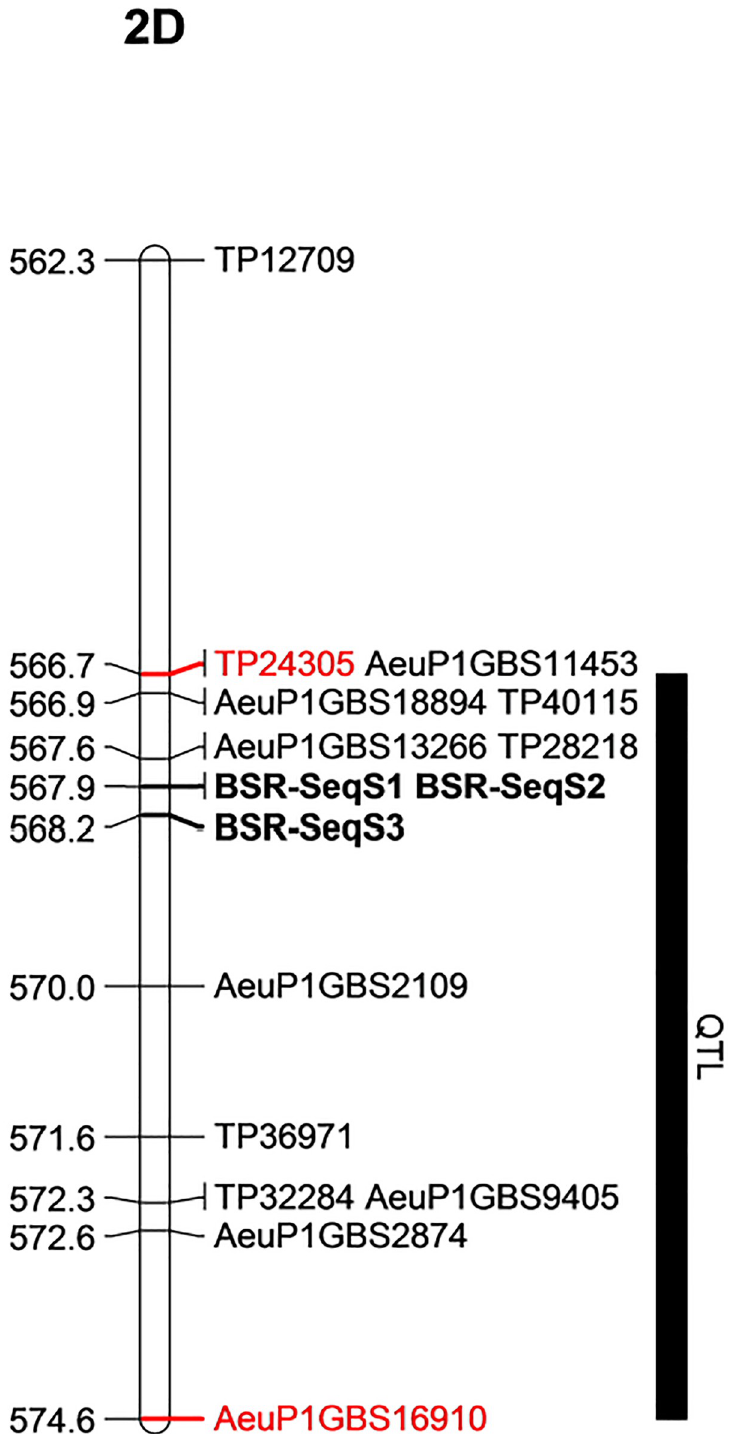
Fig 3. Physical map position of the stem resistance QTL based on Ae . tauschii reference sequence.